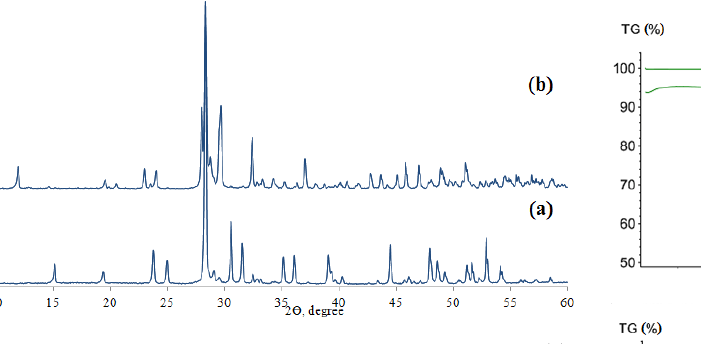
Figure 1: X-Ray pattern for BiNb 0.96 Mn 0.04 O 4− δ of orthorhombic ( α ) and triclinic ( β ) modifications.